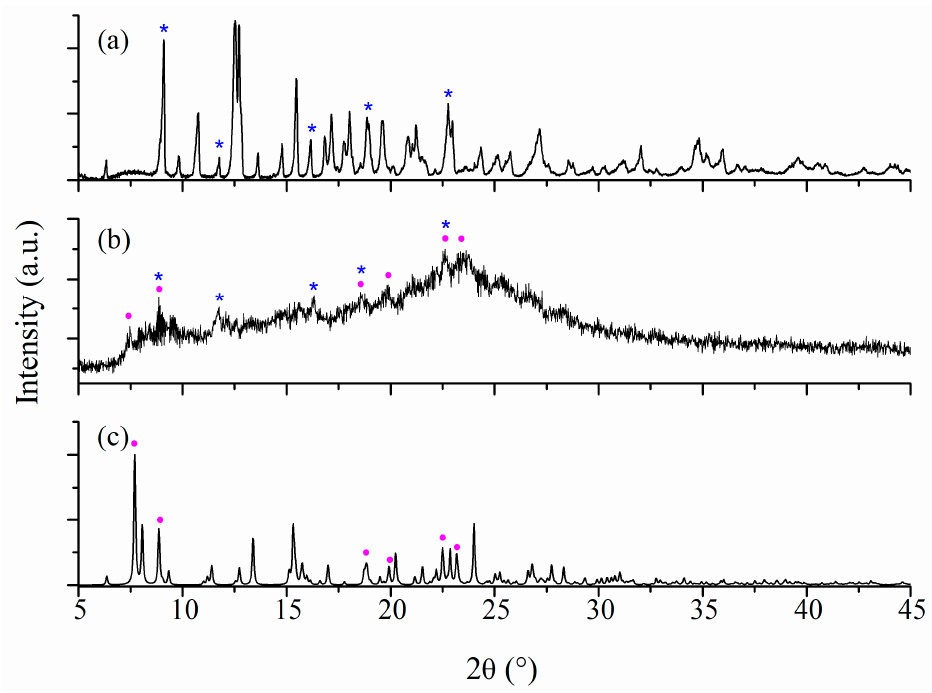
Figure 4. Powder X-ray diffractograms for β -CD (peaks marked with *) ( a ), ( 1a )@ β -CD ( b ), and simulated from single crystal X-ray analysis for ( 1 ) (peaks marked with • ) ( c ).